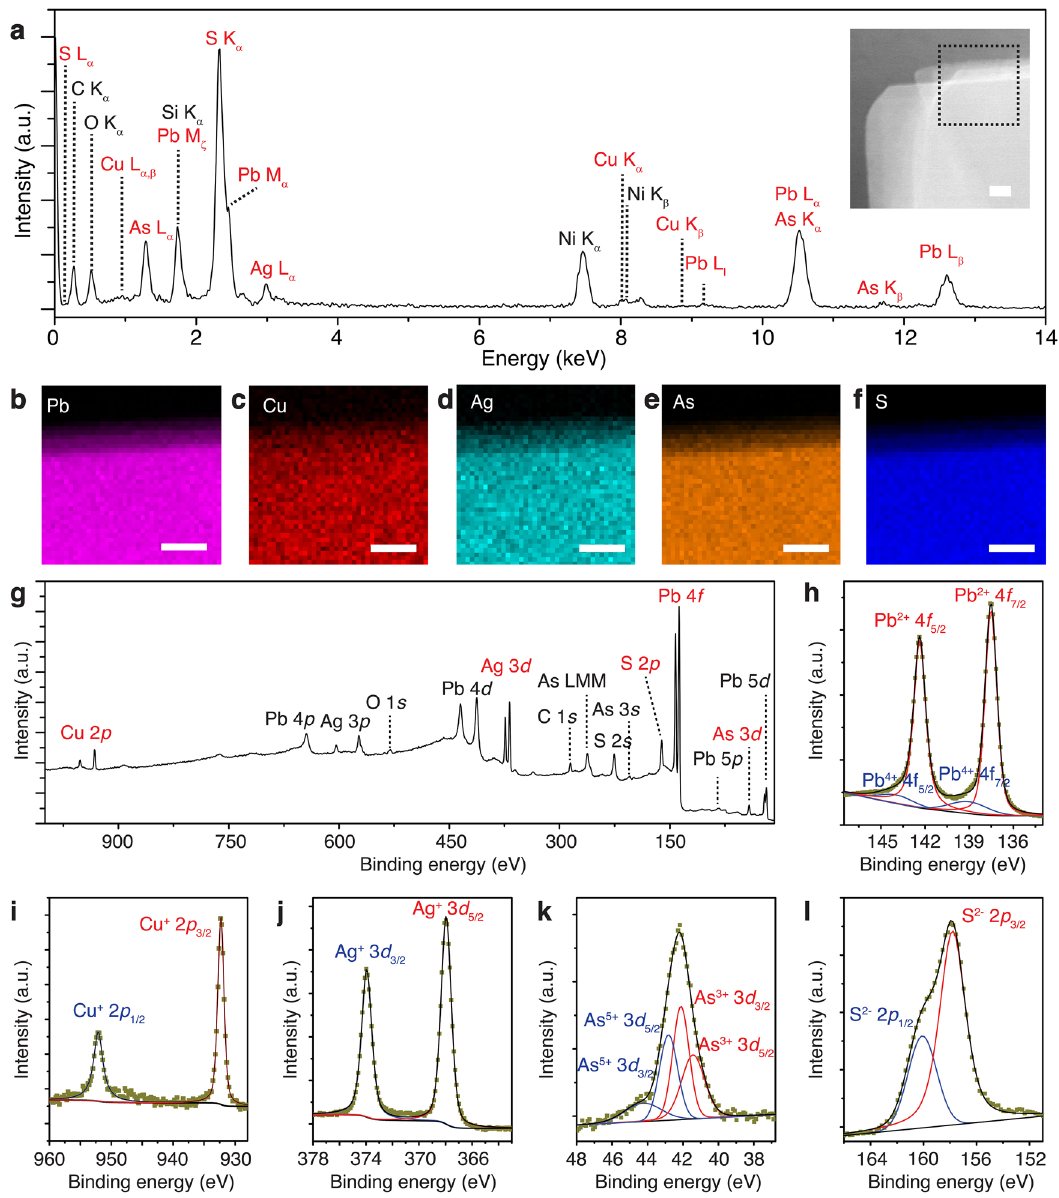
Fig. 2 Chemical composition characterization of lengenbachite crystal. a Averaged EDXS spectrum from a lengenbachite thin fl ake. The peaks of main elements Pb, Cu, Ag, As, and S labeled in red color are used for the quanti fi cation in Table 1. b – f TEM-EDXS maps of main elements Pb, Cu, Ag, As, and S acquired from the crystal area marked in the DF-TEM image in the inset of a . Scale bar is 50 nm. g Averaged XPS spectrum of lengenbachite from multiple measurements. The peaks labeled in red color are used for the quanti fi cation in Table 2. h – l High-